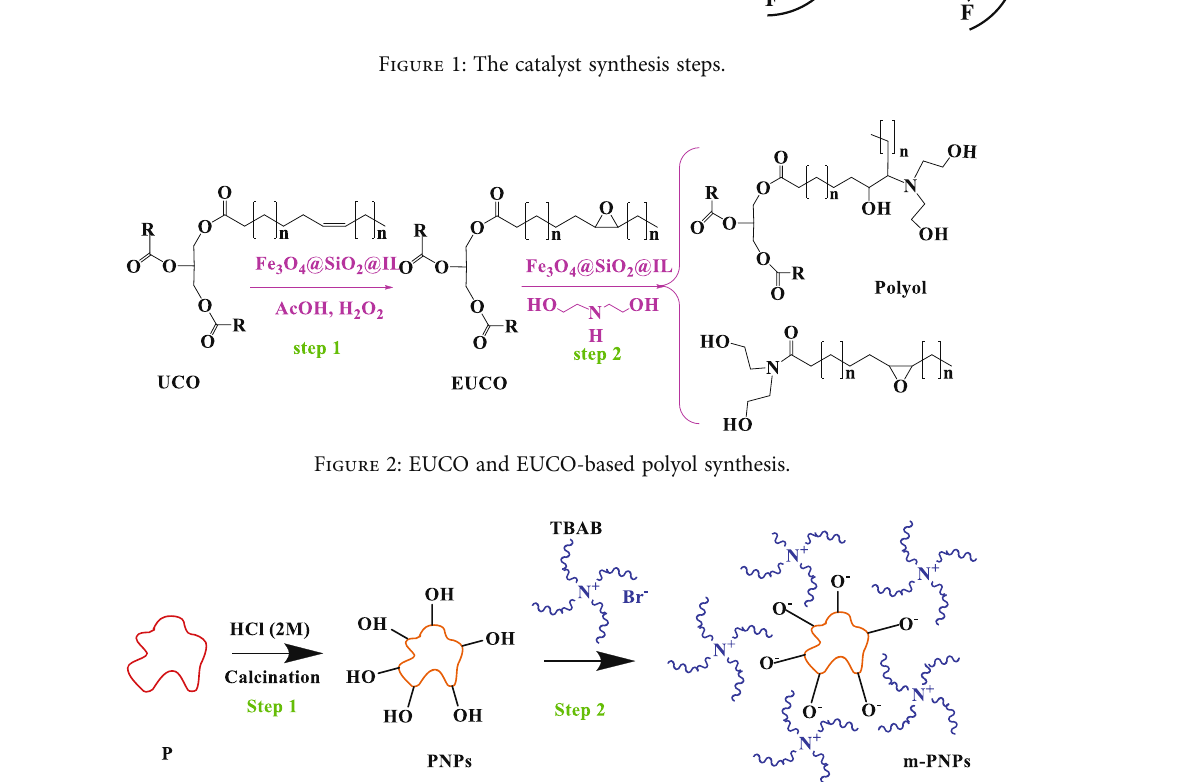
Figure 3: Modi fi ed perlite nanoparticles synthesis